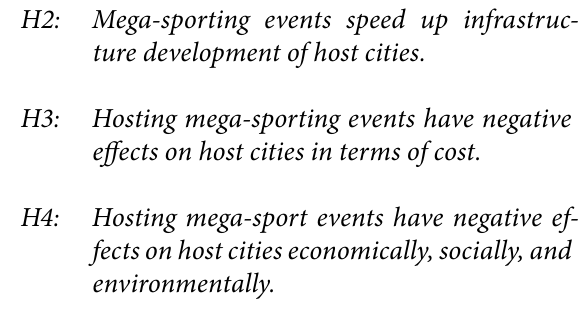
Figure 1. Mega-sporting event